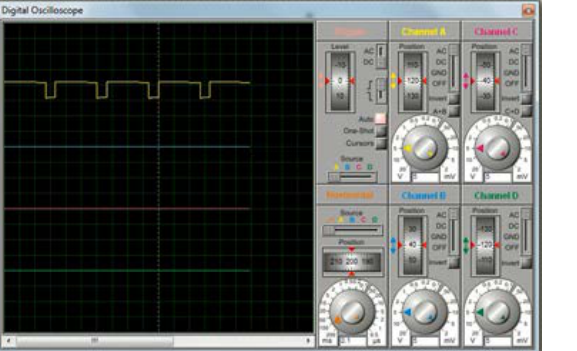
Figure 5. Output signal on the oscilloscope when the potentiometer has its maximum negative value.